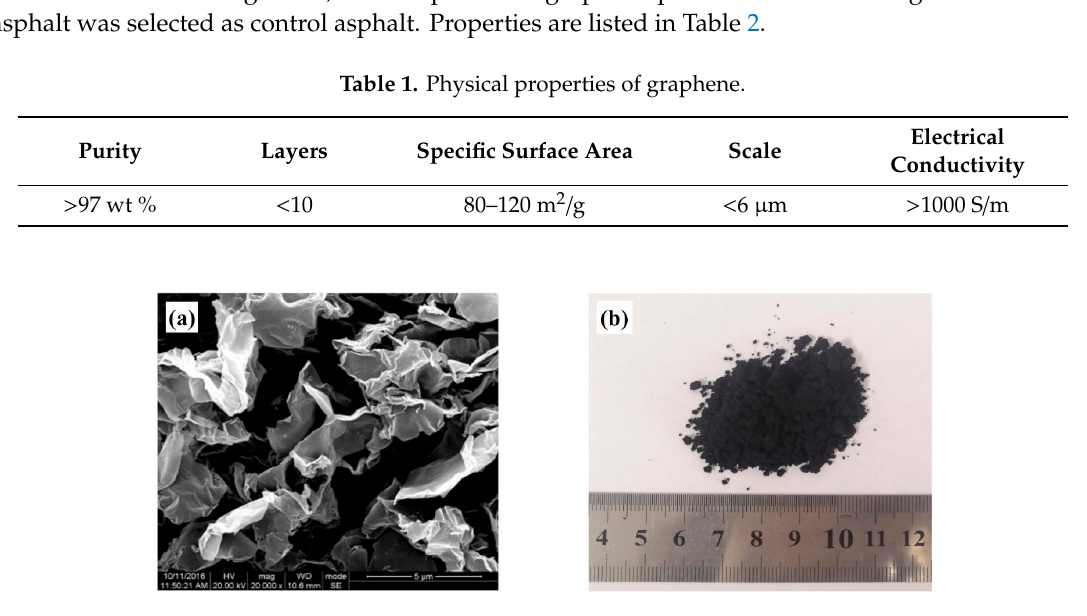
Table 2. Physical properties of 70# asphalt.